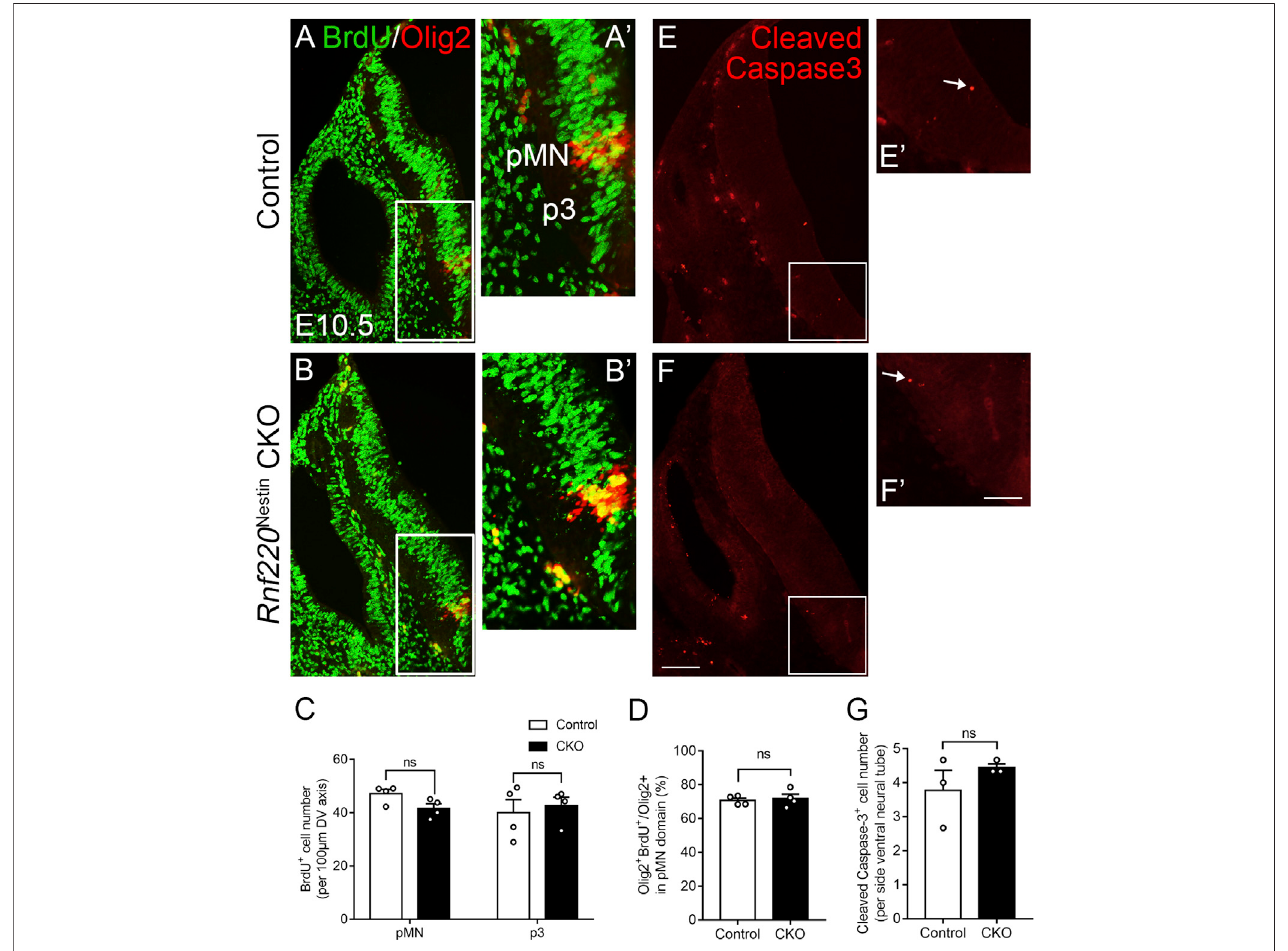
FIGURE3| NoSigni fi cantChangesinProliferationandCellDeathintheVentralHindbrainof Rnf220 Nestin CKOEmbryosatE10.5. (A – B) Doubleimmunostainingfor BrdU (green) and Olig2 (red) shows no obvious changes of proliferation in the ventral VZ of the hindbrain between Rnf220 Nestin CKO embryos and controls. (A ’ ,B ’ ) are high-magni fi cation images of boxed areas in (A,B) , respectively. (C) Quanti fi cation of the numbers of BrdU + cells per 100 μ m-length in the Olig2 + pMN domain and p3 domain of control and Rnf220 Nesin CKO embryos at E10.5. The p3 domain corresponds to the BrdU + region located ventral to the Olig2 + pMN domain. ns, no signi fi cantdifference. (D) Quanti fi cationofthepercentagesofBrdU/Olig2double-labeledcellsinOlig2 + cellsinthepMNdomainofcontroland Rnf220 Nesin CKOembryos at E10.5. (E,F) Immunostaining for Cleaved Caspase-3 shows similar cell death in Rnf220 Nestin CKO embryos compared with controls. (E ’ ,F ’ ) are high-magni fi cation images of boxed areas in (E,F) , respectively. Scale bar, 100 μ m (F) ; also applies to (A,B,E) ; 50 μ m (F ’ ) ; also applies to (A ’ ,B ’ ,E ’ ) . (G) Quanti fi cation of the numbers of Cleaved Caspase-3 + cells in the ventral neural tube in the two groups at E10.5. Data are expressed by mean ± SEM. Student ’ s t -test (n ≥ 3 for each).